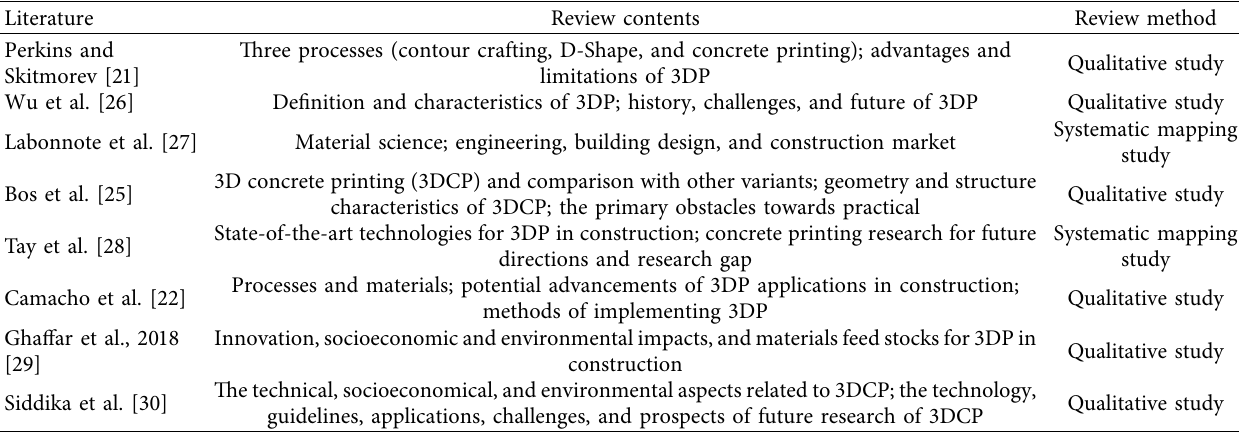
Table 1: Previous review literature of 3DPT in